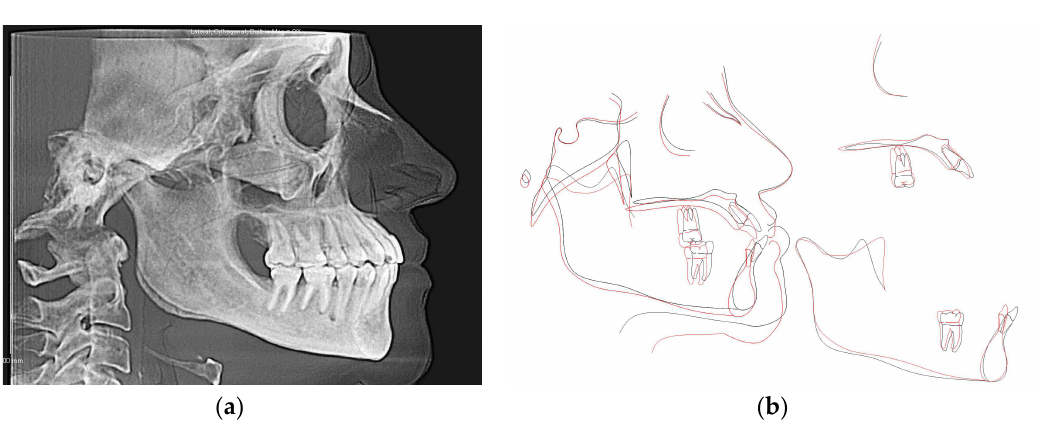
( b ) Figure 10. ( a ) Final CBCT-driven panoramic radiograph showing complete retraction of lower left canine; ( b ) final CBCT-driven sagittal screen showing bone formation labial to lower incisors compared to initial one with severely proclined lower incisor. 4. Discussion Treatment of open bite using the extraction of teeth utilizing clear aligners has been recently reported [2,3,5]; however, the use of HFV in conjunction with myofunctional therapy without gingival graft is the most important and new finding in this case report. The important observation to report here is the new bone formation labial to the initially proclined lower incisors after using HFV without gingival graft to cover the gum recession labial to the affected lower incisor (Figure 6 b). It has been reported before that HFV not only can accelerate tooth movement with clear aligners [10–12] but also it increase bone formation and density after orthodontic treatment and after extraction of teeth as well [12–16]. Previous reports have shown that the increased bone density effect of HFV is mediated through its upregulation of osteogenic transcription factors (RUNX2, Foxo1, Osterix and Wnt signaling factors) [13]. The biological mechanism of accelerating tooth movement by HFV has been reported in detailed before [16]. This supports the reported findings in this case report that new bone formation has been observed labial to lower incisors after orthodontic treatment and the use of HFV. This also supports the hypothesis that the increased bone density by HFV can be helpful during the retention period [12], though this needs to be studied in detail in future studies.